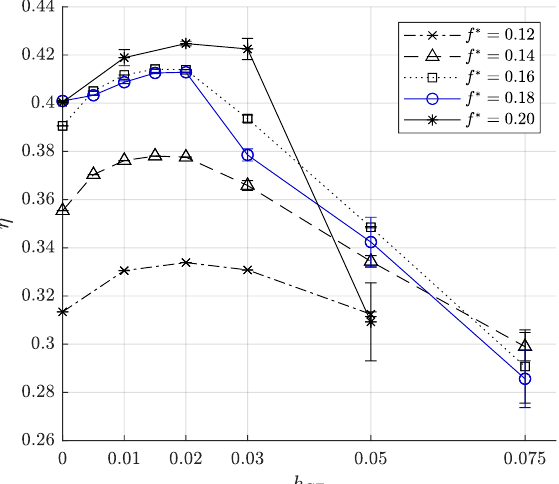
Figure 9. Effect of Gurney flaps on the performance of OFTs operating at reduced frequencies from f ∗ = 0.12 to 0.20, fitted with double GFs of h GF = 0.005 c to 0.075 c .